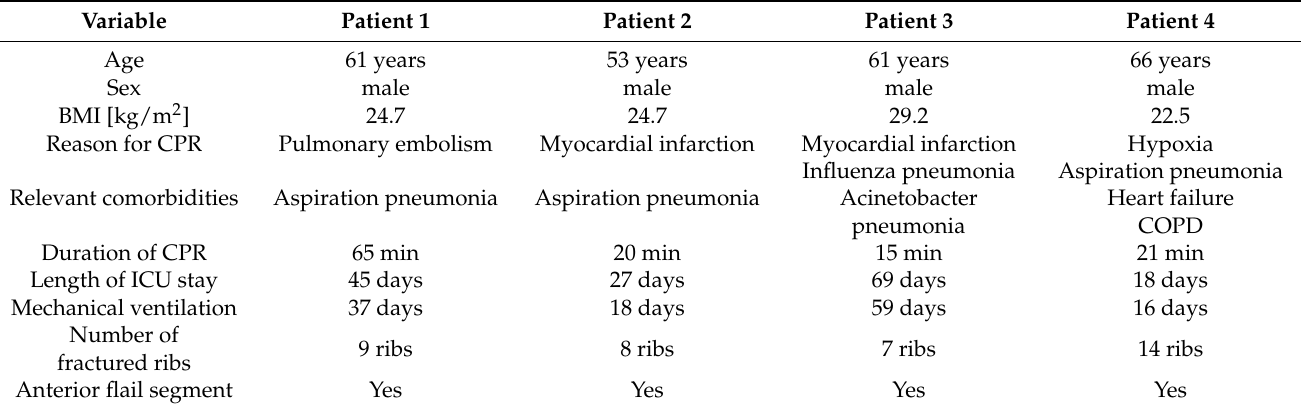
Table 7. Case characteristics of patients who underwent surgical rib